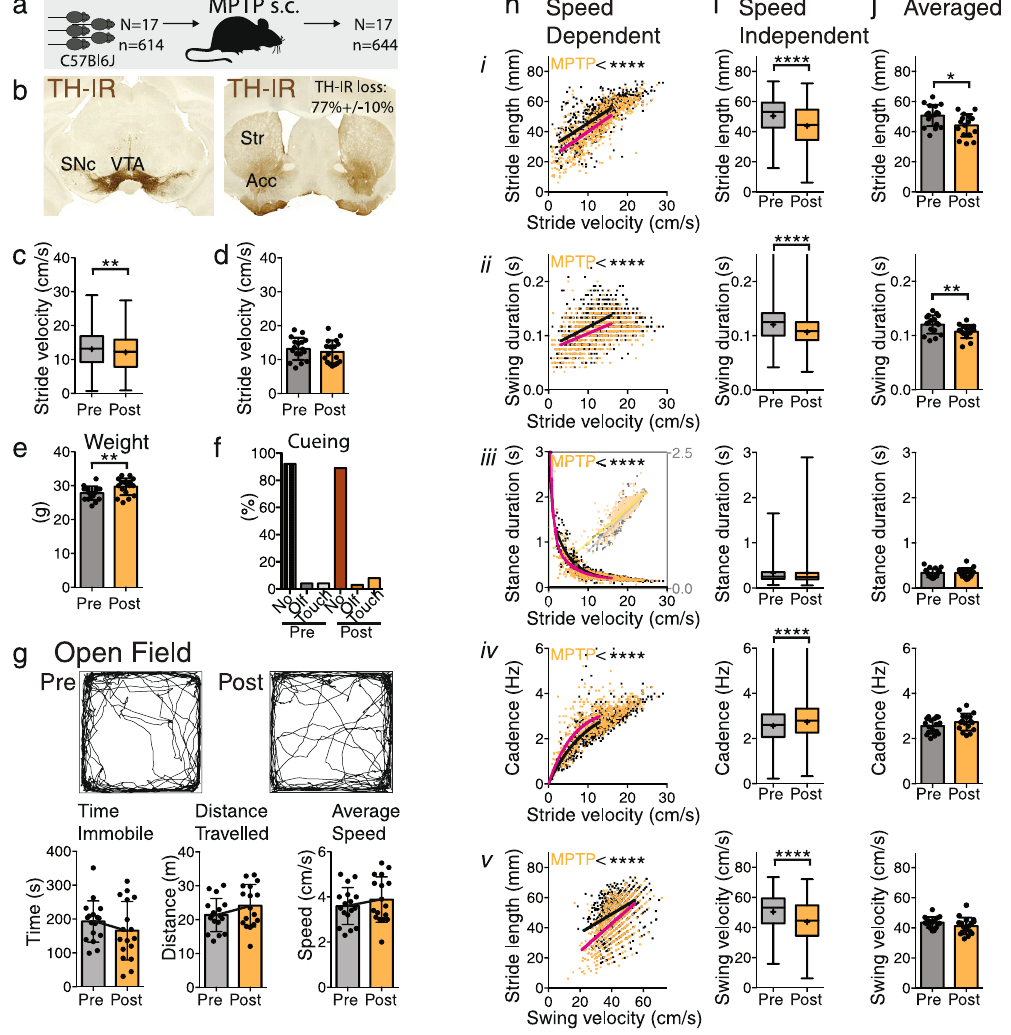
Figure 3. Effects of MPTP treatment on gait. ( a ) In 17 C57Bl6 mice gait and locomotor activity was studied before and after s.c. MPTP treatment. ( b ) MPTP induced bilateral loss of tyrosine-hydroxylase immunoreactivity in the striatum. ( c and d ) Velocity was significantly lower post MPTP as determined by stride to stride data (Mann Whitney Rank test; Supplementary Table S3), but this was not detected in the averaged data sets (2-tailed paired t-test; Supplementary Table S3). (e) Post MPTP animals gained weight (paired, 2-tailed t-test). ( f ) Cueing was not necessary to obtain sufficient trials or data points. ( g ) Open field performance was not different pre and post MPTP treatment. ( h ) Relationships of stride length ( i ), swing duration ( ii ), stance duration ( iii ), cadence ( iv ) as a function of stride velocity and stride length as a function of swing speed ( v ). The fit of one curve to both data sets was compared with the fit of individual curves fit to each dataset. All gait parameters showed highly significant differences with shortened stride length, decreased swing and stance duration, and increased cadence (F test, Supplementary Table S3). ( i ) ( i-v ): The distribution of the stride-to- stride data showed significant differences in the same gait parameters as the speed dependent analysis, except for stance duration. However, these are difficult to interpret due to changes in velocity in the stride-to-stride data sets (Mann Whitney Rank test, Supplementary Table S3). ( j ) ( i-v ): Averaged data sets revealed decreased stride length and swing durations, but no changes in other gait parameters (paired 2 tailed t-test; Supplementary Table S3). Asterisks indicate level of